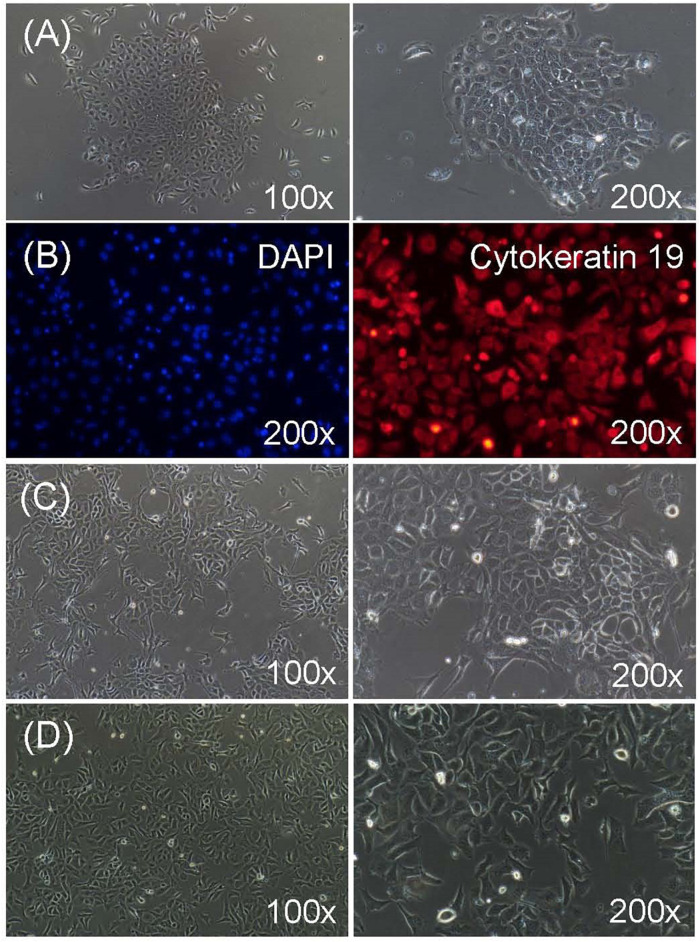
Characterization of ruminal epithelial cells from sheep (RECs). (A) Morphology of isolated primary RECs. The cell aggregates were well-attached in 24 h of culture. (B) Immunofluorescence staining of primary RECs. Cytokeratin 19: fluorescent image showing stained cytokeratin 19; DAPI: negative control when only secondary antibody was used; nuclei were stained with DAPI. (C) Morphology of successfully immortalized REC induced by SV40T after puromycin selection. (D) Morphology of immortal RECs after 30 passages of culture without showing any signs of senescence.